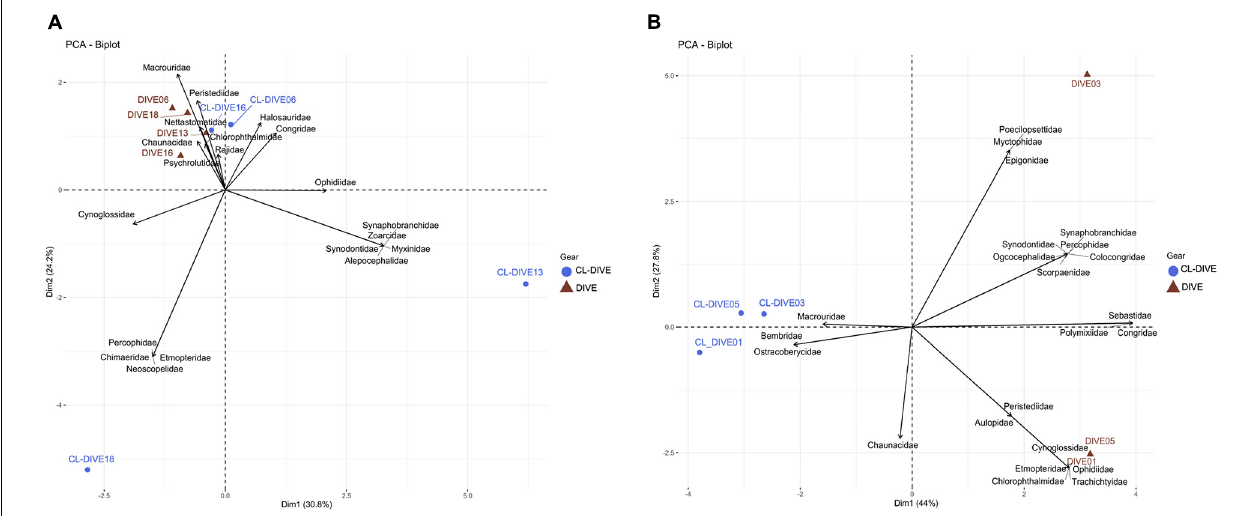
FIGURE 5 | Comparison of fish assemblages between imagery (dive) and sampling along dive (cl-dive) along (A) sedimented slope habitats (PNG) (55% of variance on first two PCs) and (B) volcanic island slopes (Mayotte) (71.8% of variance on first two PCs). Principal Component Analysis (PCA) of Hellinger-transformed presence/absence fish data at family